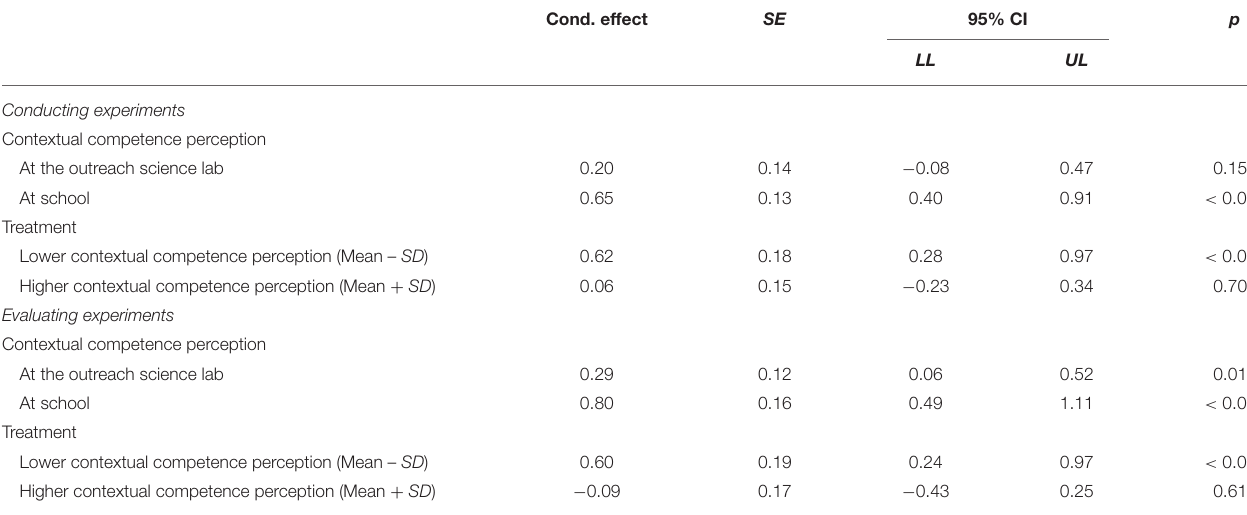
TABLE 4 | Estimation of the conditional effects of students’ contextual competence perception (pre-test) and treatment on the situational competence experience (post-test).